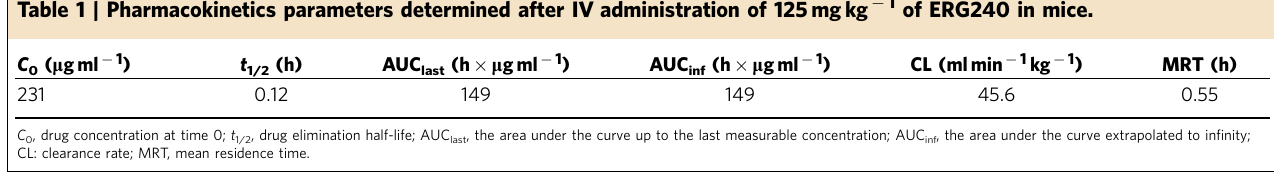
Table 2 | Pharmacokinetics parameters determined after oral administration of 500mg kg (cid:2) 1 of ERG240 in mice. C max ( l gml (cid:2) 1 )